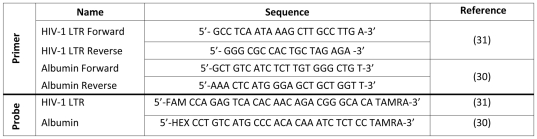
Primers and probes used in this study.The original sources and sequences of the primers and probes used in this study are summarised. The fluorophores used were FAM and HEX for the HIV-1 LTR and albumin probes, respectively. The quencher used for both probes was TAMRA.